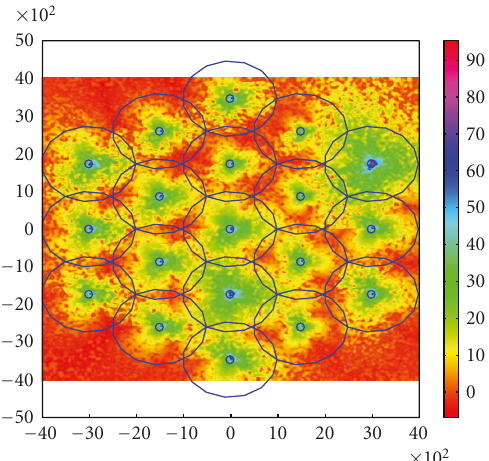
Figure 5: 19-cell configuration, SINR